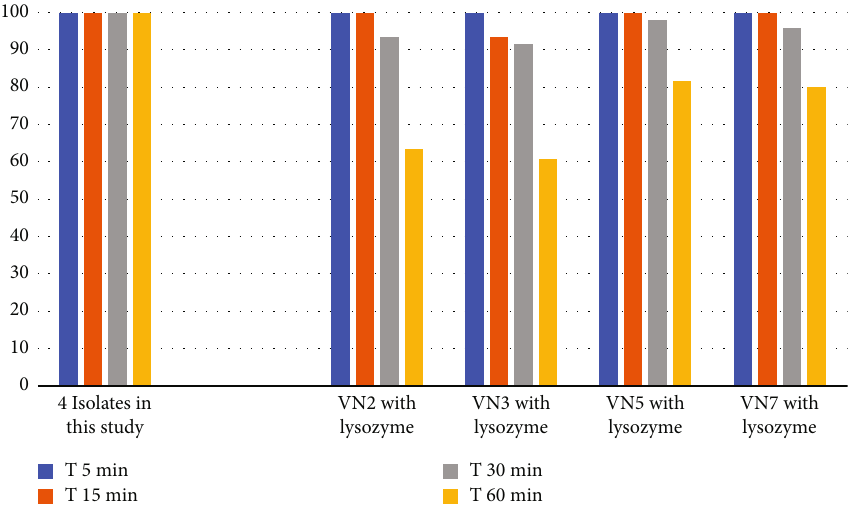
Figure 6: Lysozyme tolerance activity of VN2, VN3, VN5, and VN7, respectively.